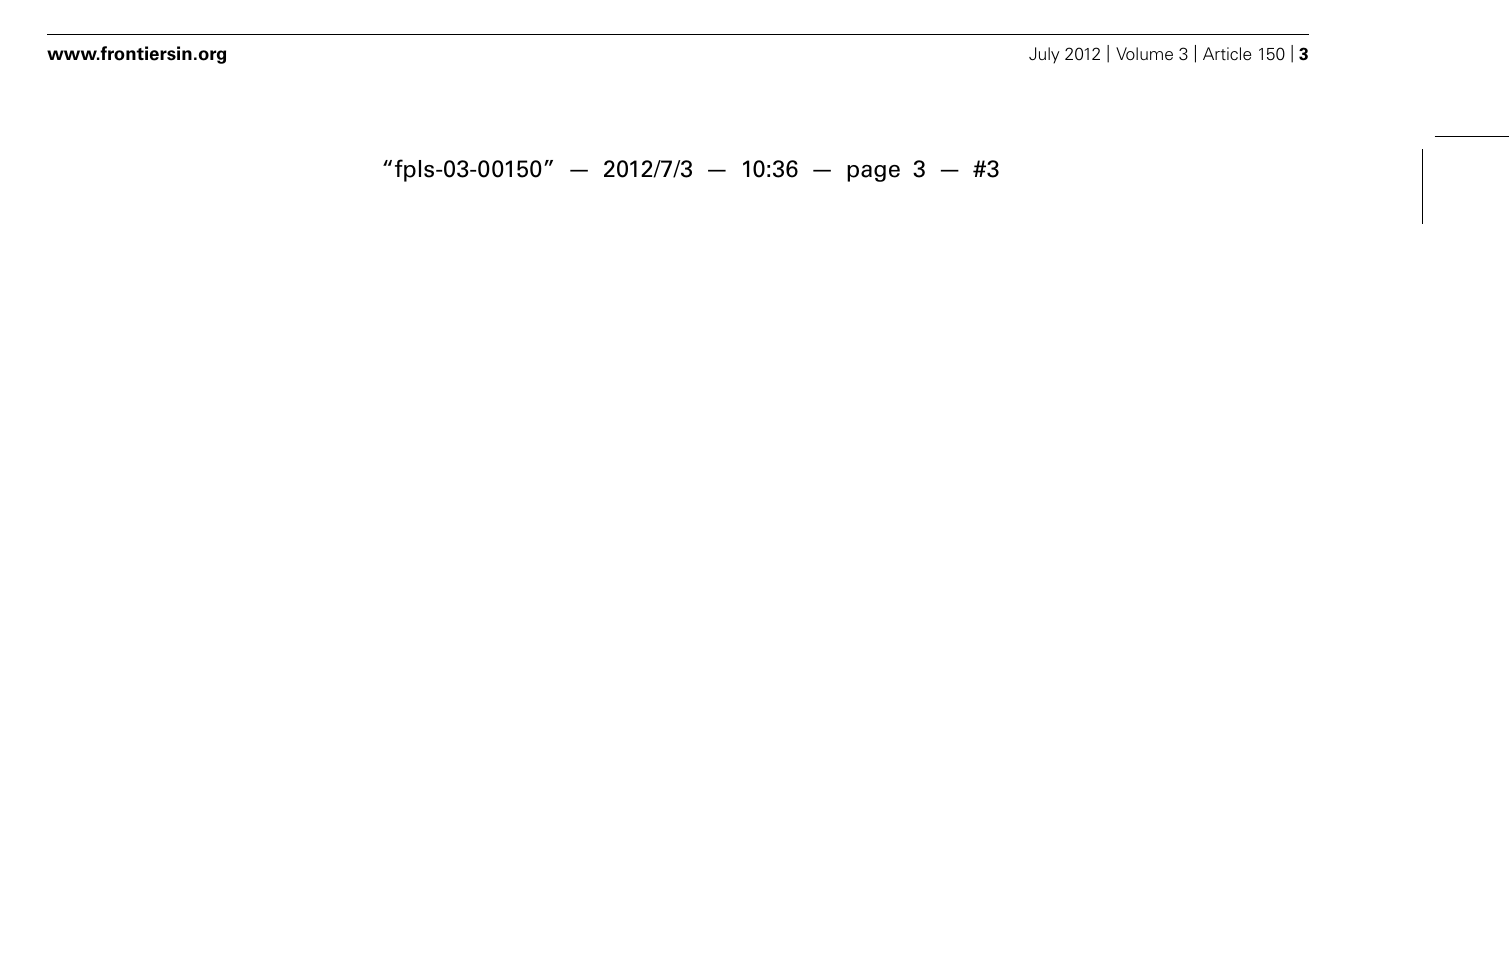
(A) or transferred onto nitrocellulose membrane for immunoblotting using antisera that recognize β -1,2-xylose (B) or α -1,3-fucose (C)